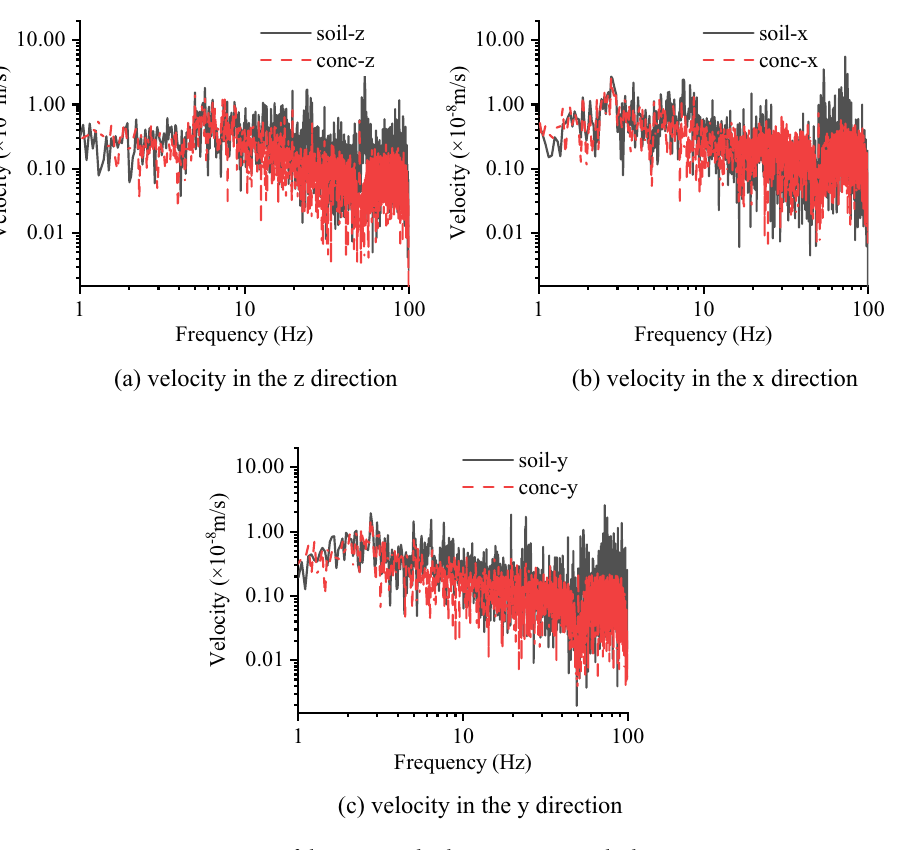
Figure 18. Frequency spectrum of the measured velocities at 4:00 at the long term monitoring